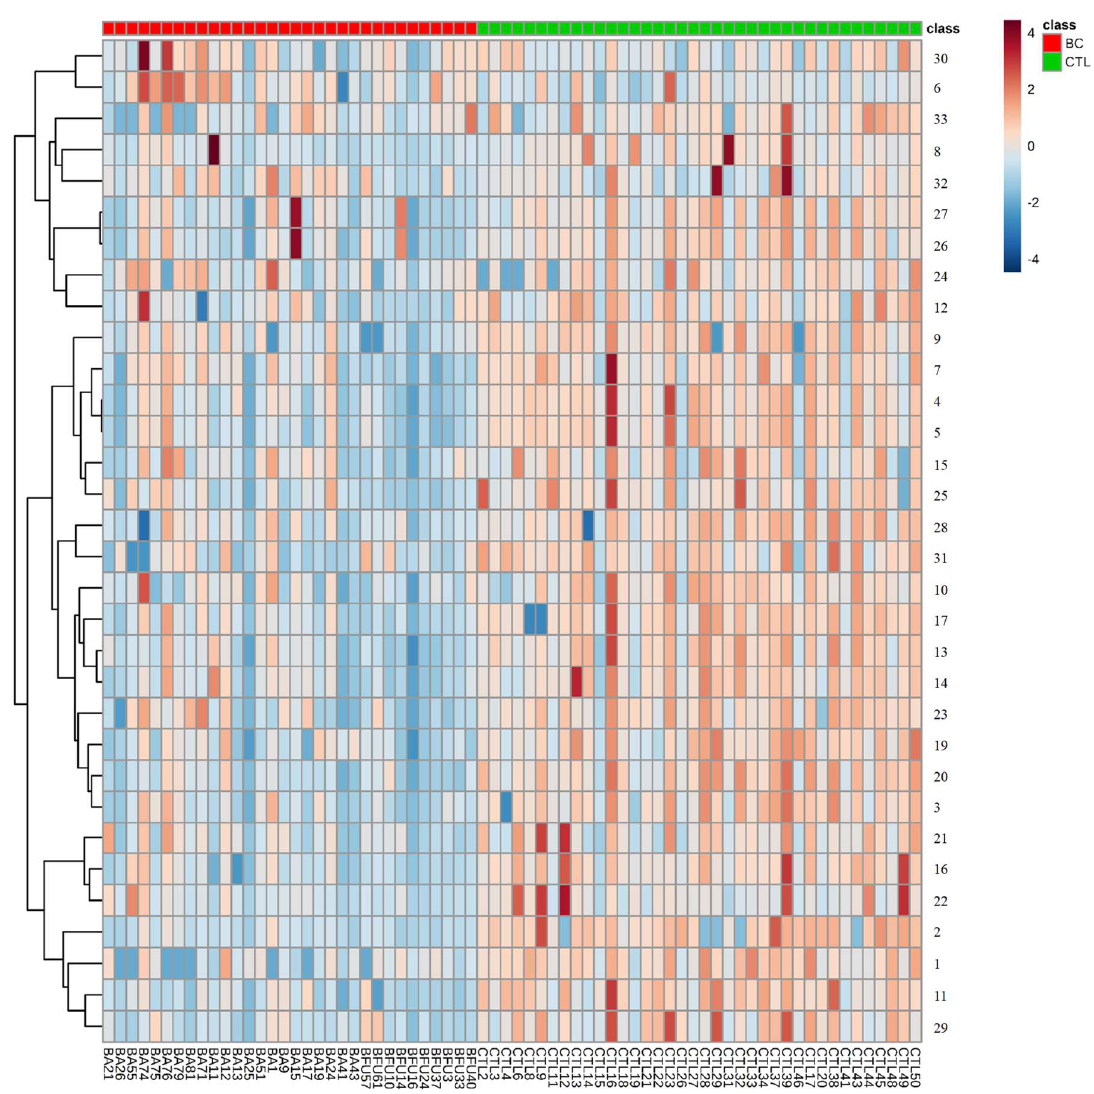
Figure 3. Heat map visualization and hierarchical clustering analysis by Pearson’s distance analysis.